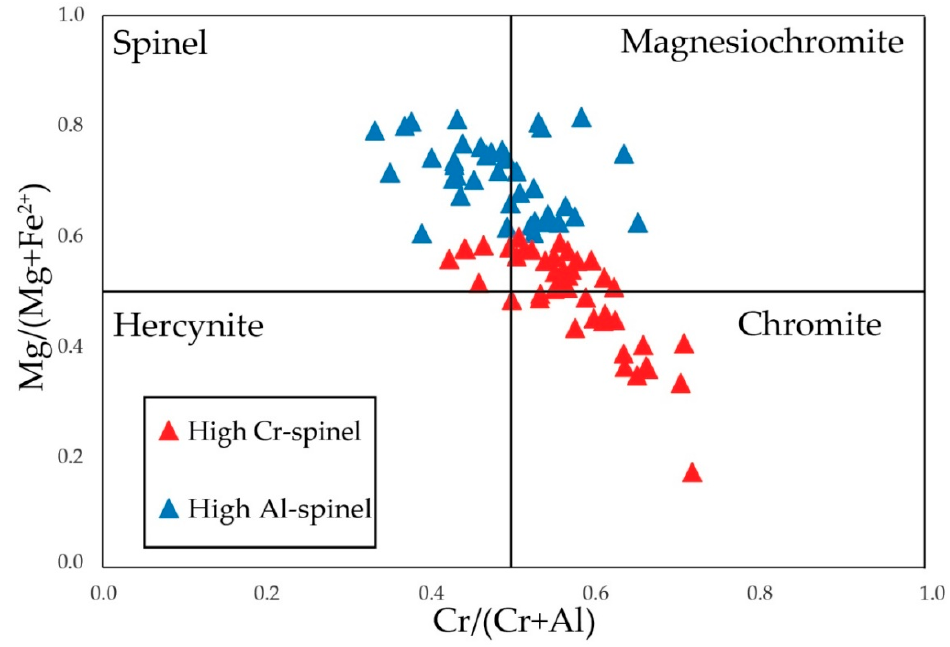
Figure 8. Classification of the composition of chromian spinels from the Waropen Regency (after [50]).